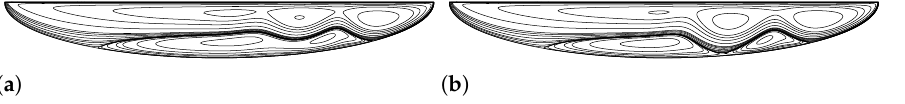
Figure 8. Bifurcation of the solution in driven semi-elliptical cavity flow with D = 0.26 aspect ratio. ( a ) Re = 7412 (1st solution). ( b ) Re = 7413 (2nd solution).